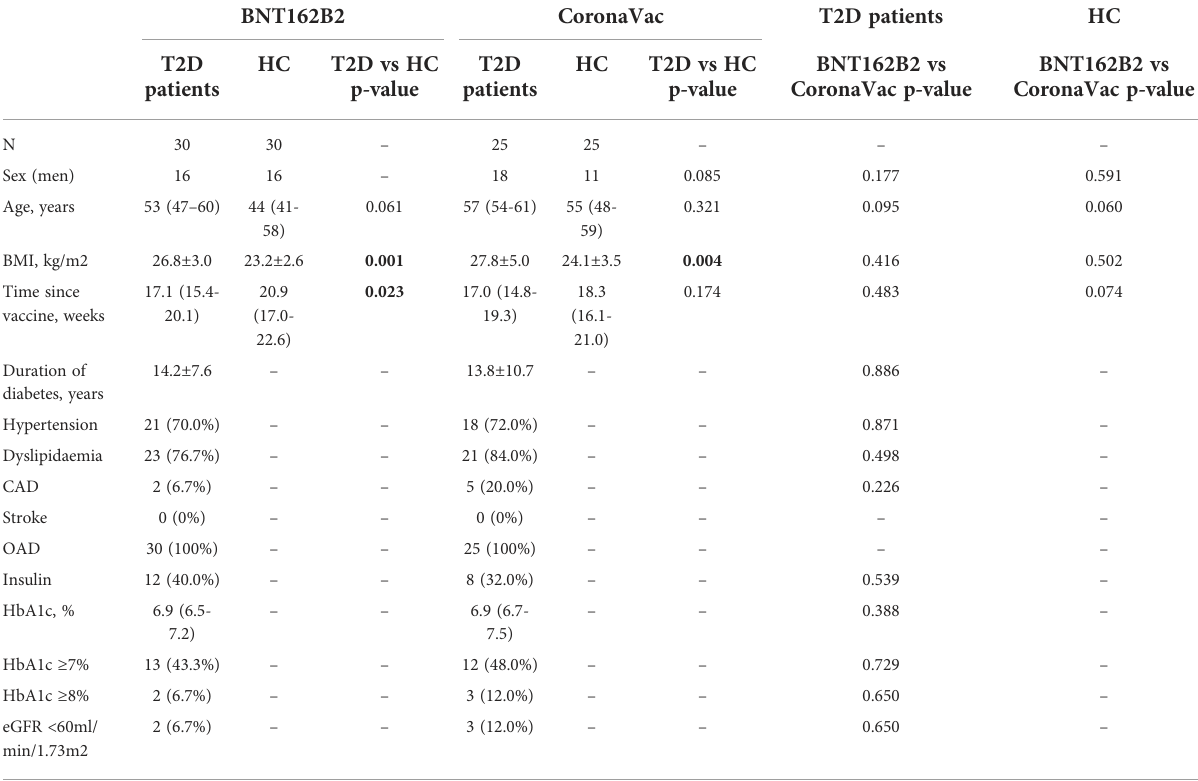
TABLE 1 Baseline characteristics of the participants in Part 1 of the study